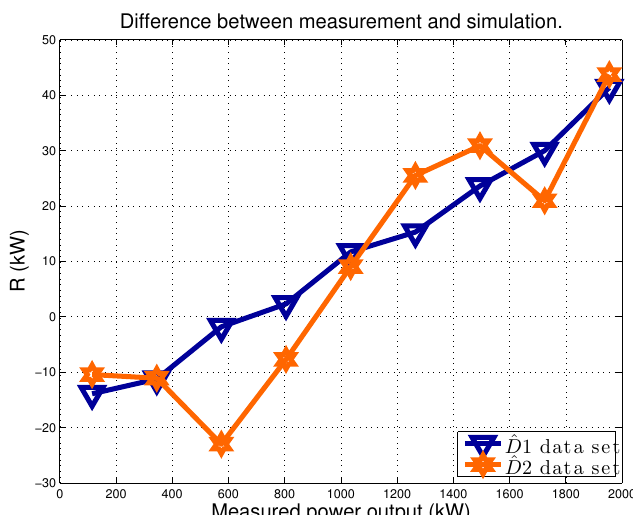
Figure 5. The average difference R between power measurement y and estimation ˆ y (Equation (4)). Data sets: ˆ D 1 and ˆ D 2. Sample run of the